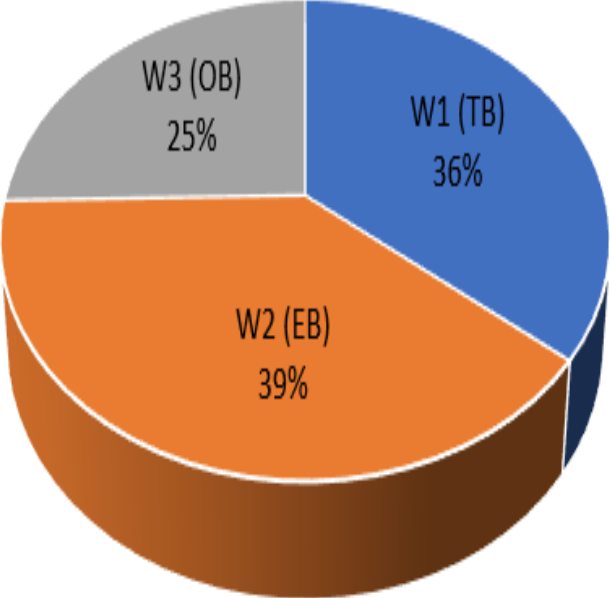
Figure 3. Priority distribution for main barriers.